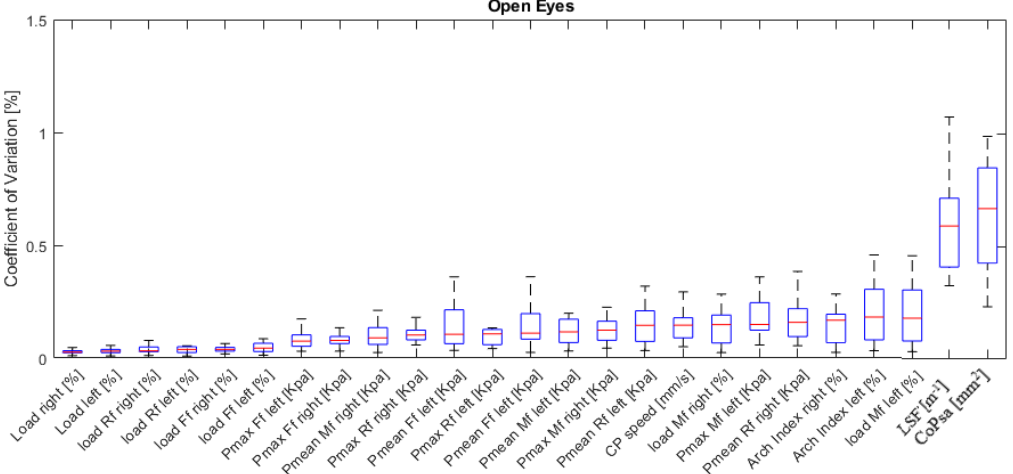
Figure 3. Boxplot of inter-subject coefficient of variation (%) of stabilometric and pressure parameters sorted in ascending order to median values. Forefoot (Ff); midfoot (Mf); rearfoot (Rf); mean pressure (Pmean); maximum pressure (Pmax); center-of-pressure speed (CP speed); length surface function (LSF); center-of-pressure sway area (CoPsa).